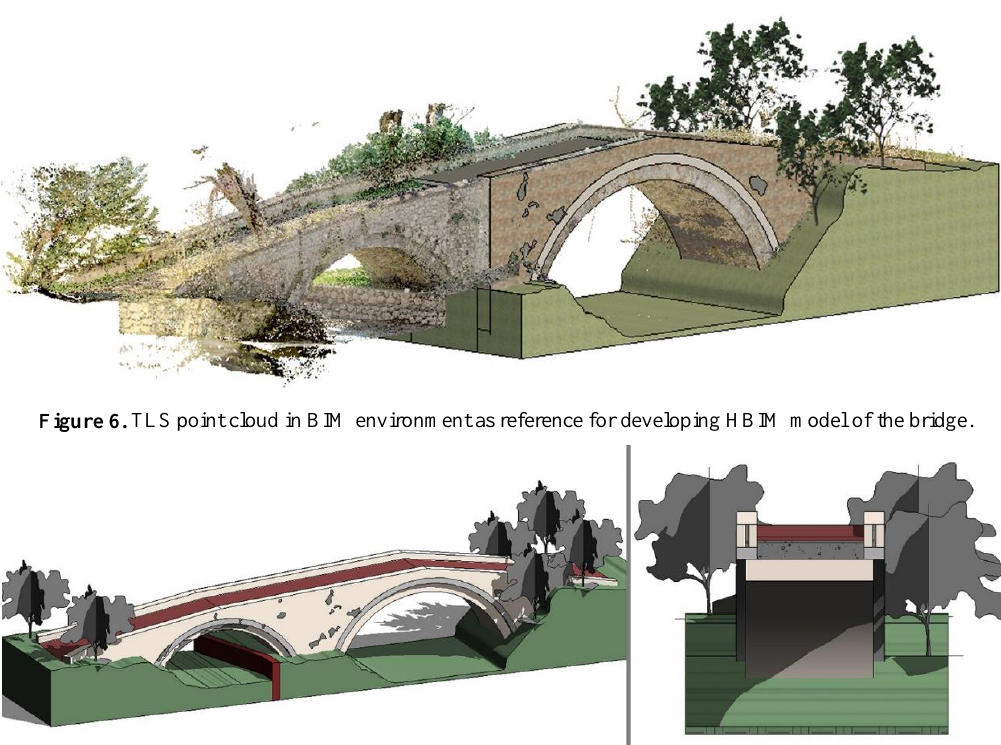
Figure 7 . HBIM model: on the left, 3D view; on the right, section